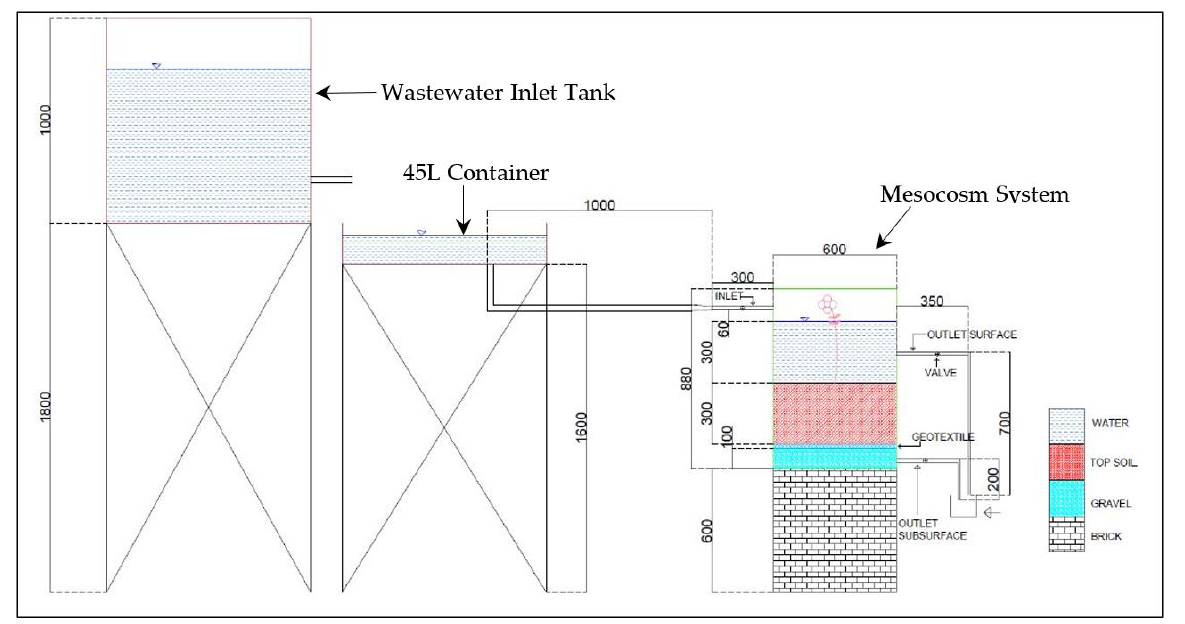
Figure 1. Wetland mesocosm experimental setup. The experimental setup consists of a wastewater inlet tank, 45 L containers, and 45 units of mesocosm columns.